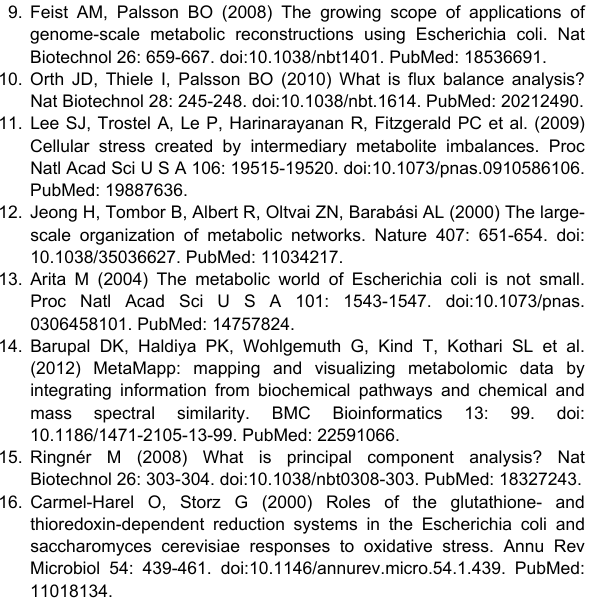
Figure S1. Principal component analysis of metabolome profiles of wild-type, galT, galU , and galE strains in the presence or absence of D-galactose.